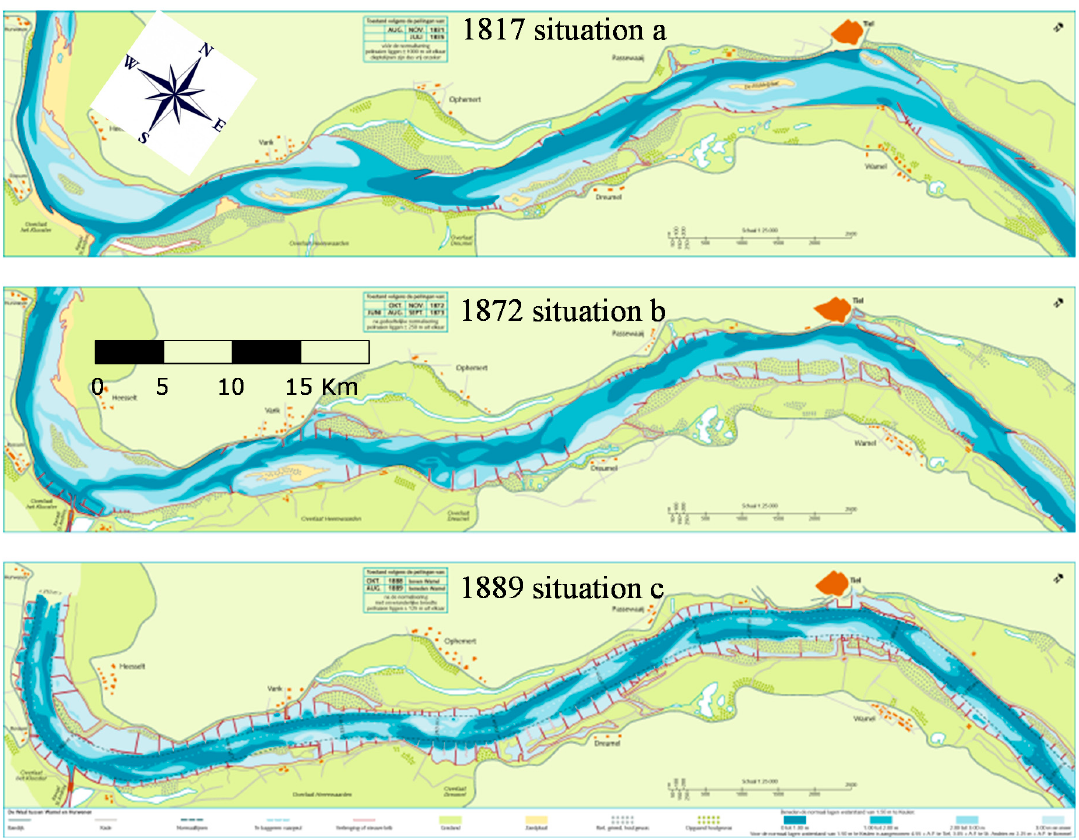
Figure 2. Stages in the normalization in the 19th century (copyright RWS).